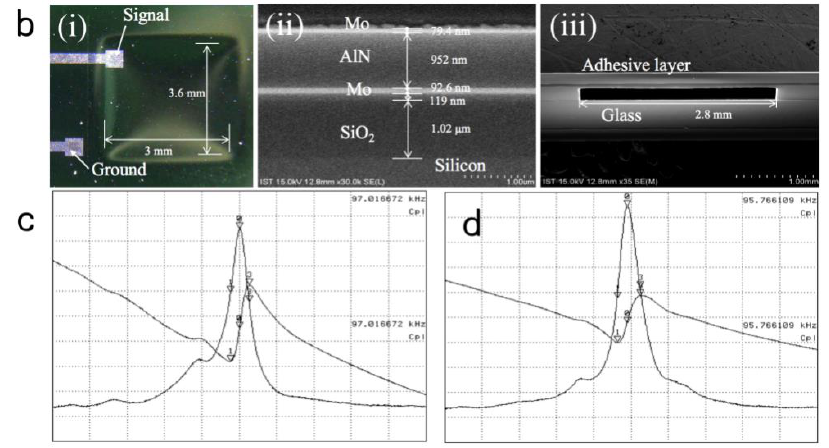
Figure 3. The fabrication and characterization of PMUTs. ( a ) The process flow of the air-coupled PMUT based on AlN. ( b ) Optical microscopy (OM) and SEM imaging of the PMUT (the adhesive layer is added for SEM imaging). ( c ) Analysis of impedance characteristics of transmitter (97 kHz), and ( d ) receiver (96 kHz).